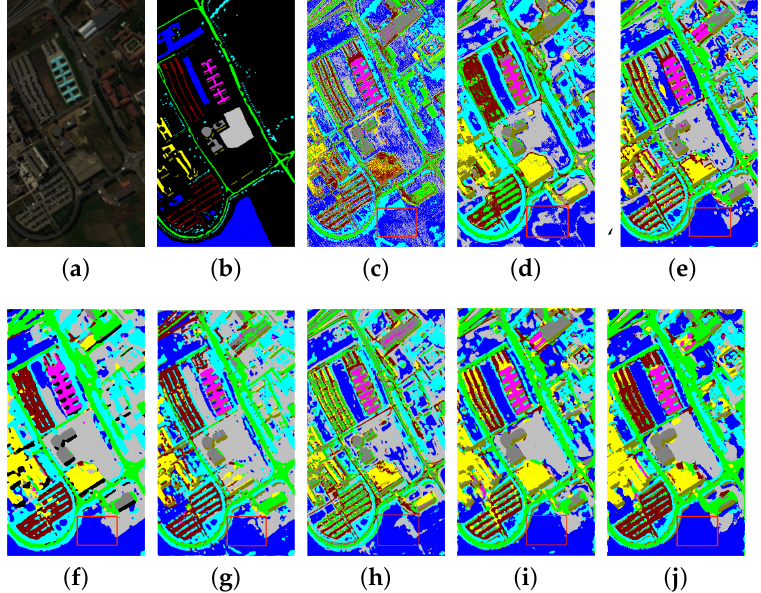
Figure 11. Classification maps for the University of Pavia dataset with 20 labeled training samples per class. ( a ) False color image; ( b ) ground truth map; ( c ) SVM; ( d ) SVMCK; ( e ) DcCapsGAN; ( f ) LMAFN; ( g ) SSRN; ( h ) SSFCN; ( i ) TFNet; ( j )